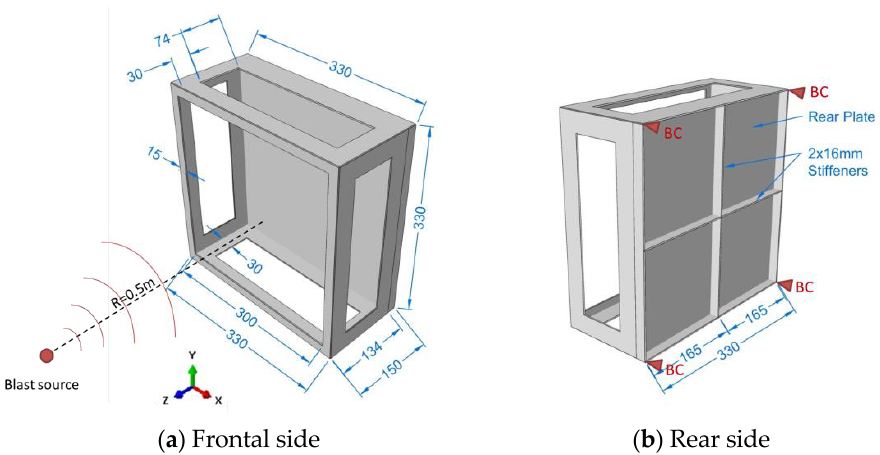
Figure 3. The 3D views of the steel frame that holds the corrugated core of the sandwich panel. ( a ) Frontal side; ( b ) Rear side.